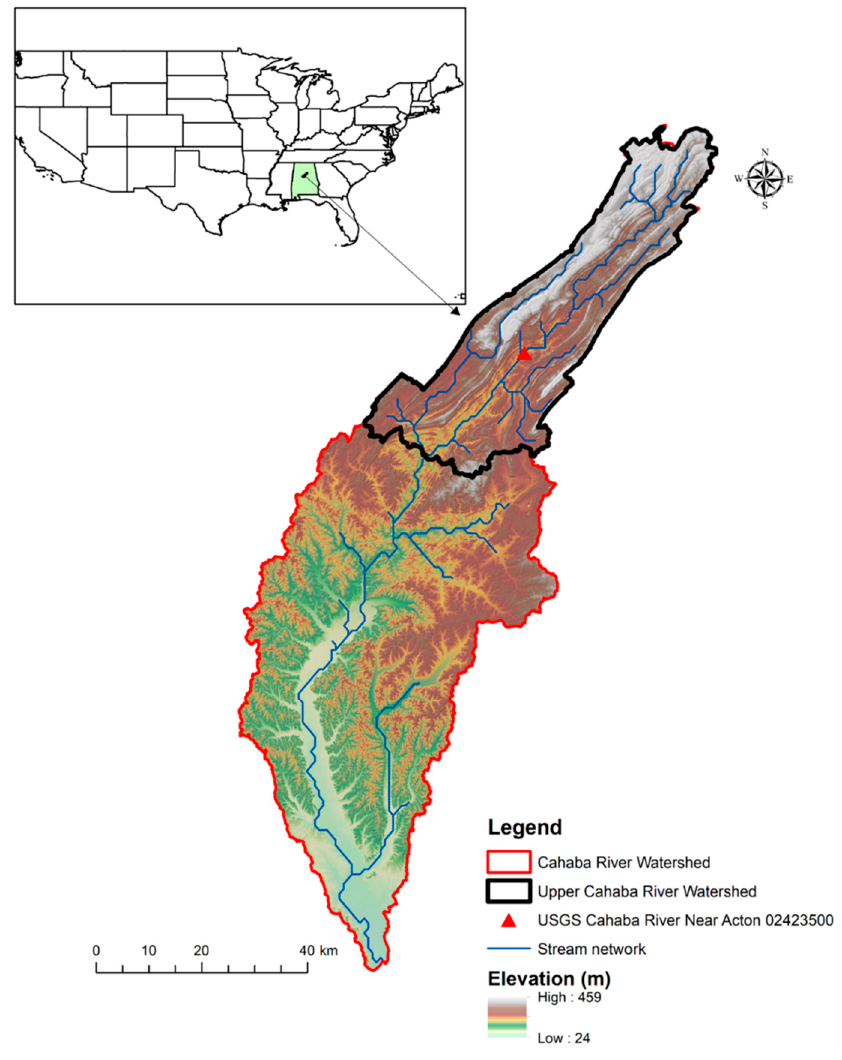
Figure 1. Location of the Upper Cahaba River watershed. Table 1. Land use/cover classes and changes in the Upper Cahaba River watershed.